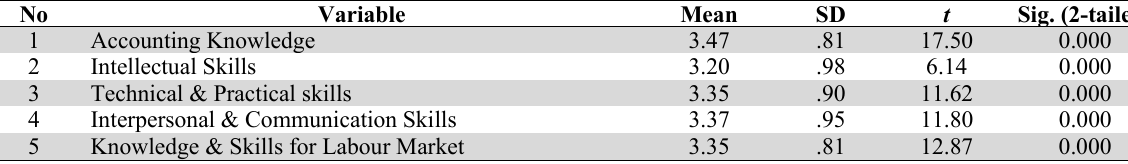
Results of t test for Accounting knowledge and